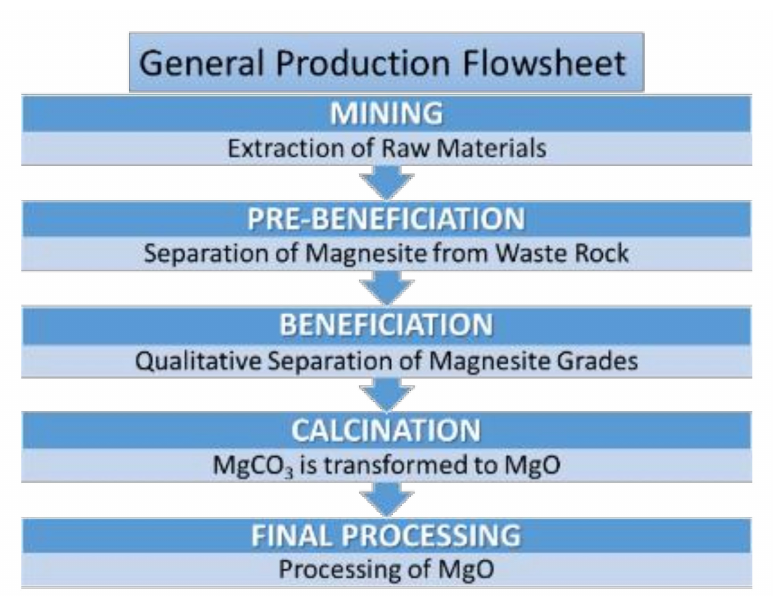
Figure 2. GM’s general production flowsheet.